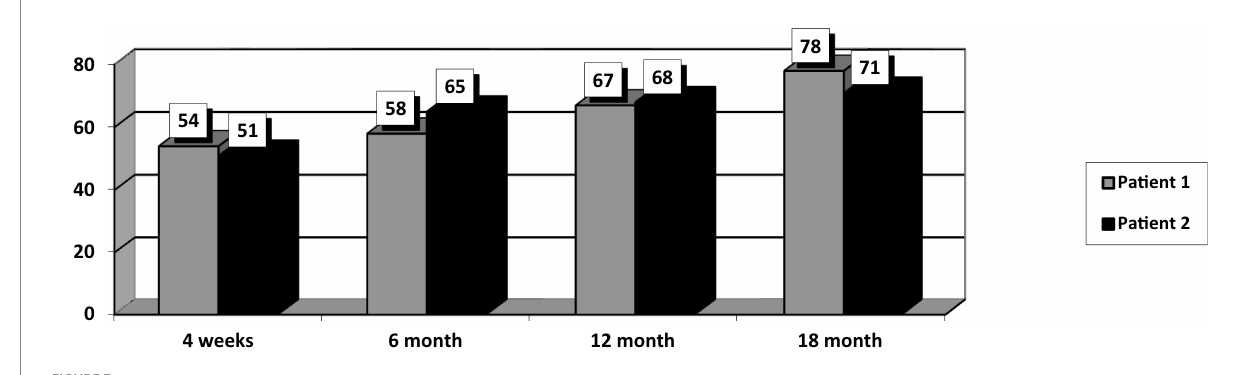
FIGURE 3 Dynamics of the mean GAF scores in the course of therapy with Cariprazine.